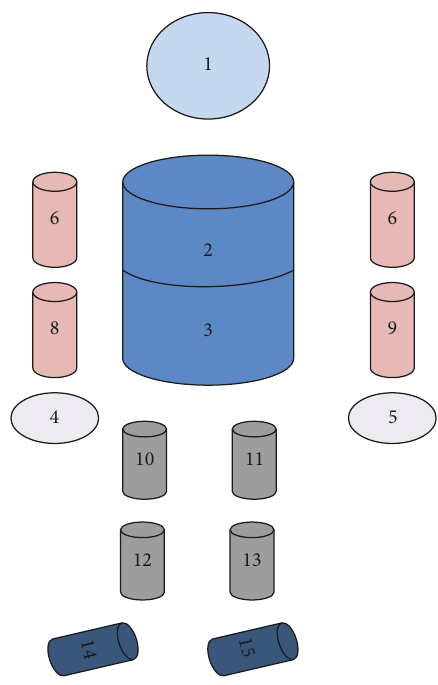
Figure 4: Multirigid body model.